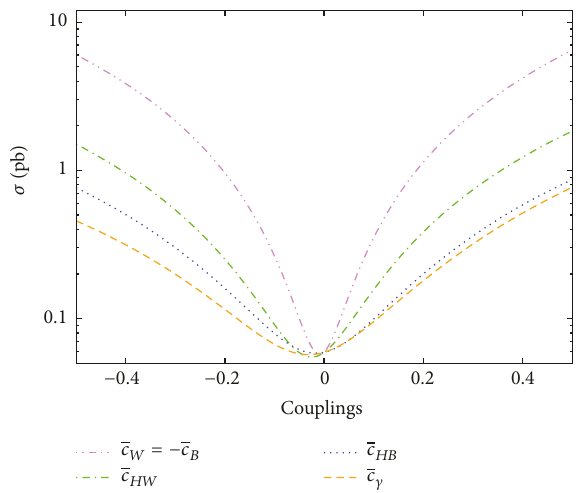
Figure 2: The total cross section as a function of CP-conserving 𝑐 = −𝑐 𝑐 𝑐 𝑐 푊 퐵 , 퐻푊 , 퐻퐵 , and 훾 couplings for the CLIC with √𝑠 = 380